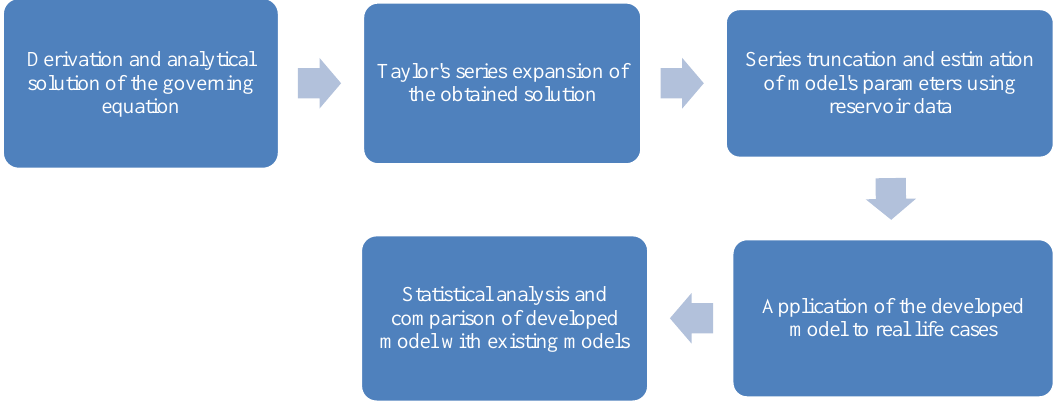
Series truncation and estimation of model's parameters